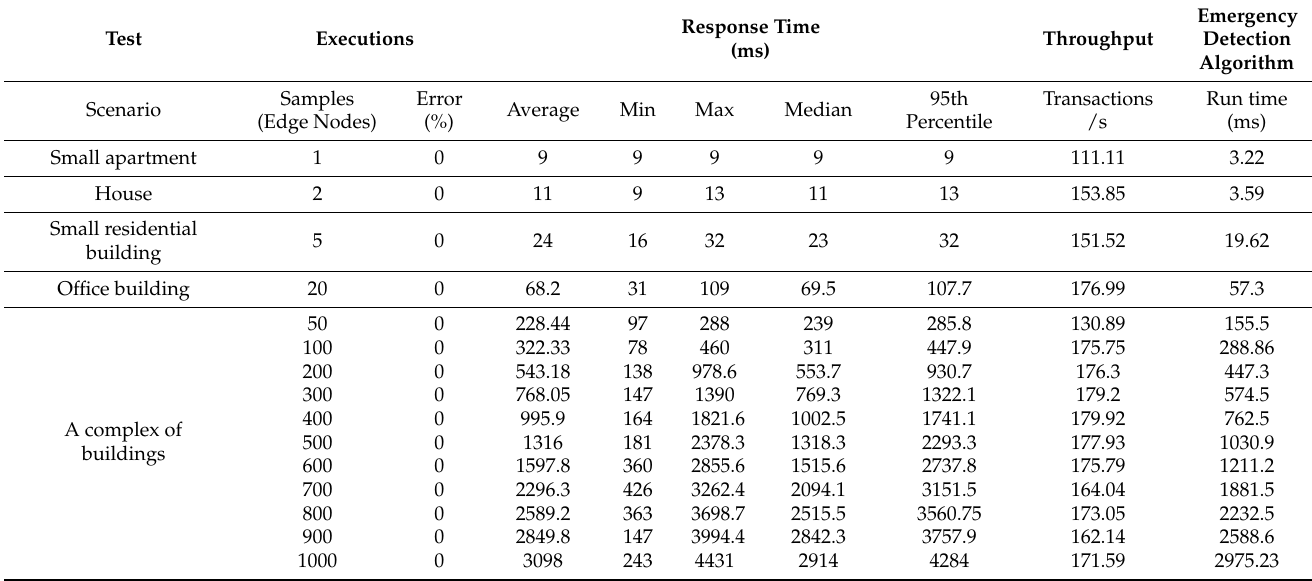
Table 2. Summary of test results for the Docker Desktop local